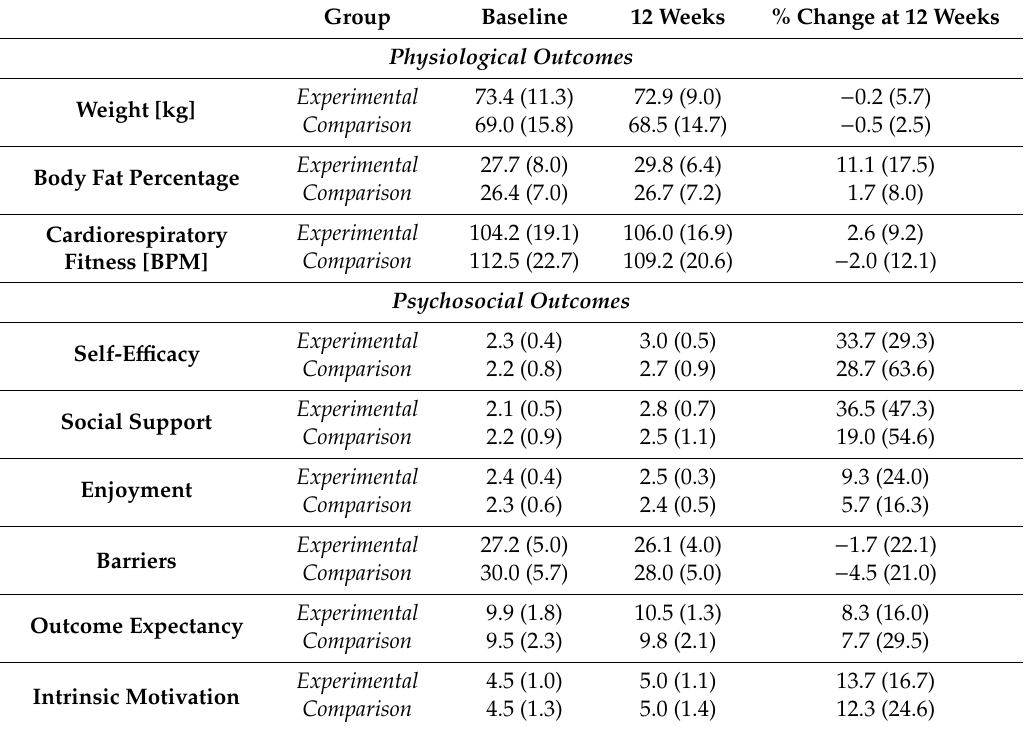
Table 4. Physiological and Psychosocial Outcomes by Group at Baseline and 12